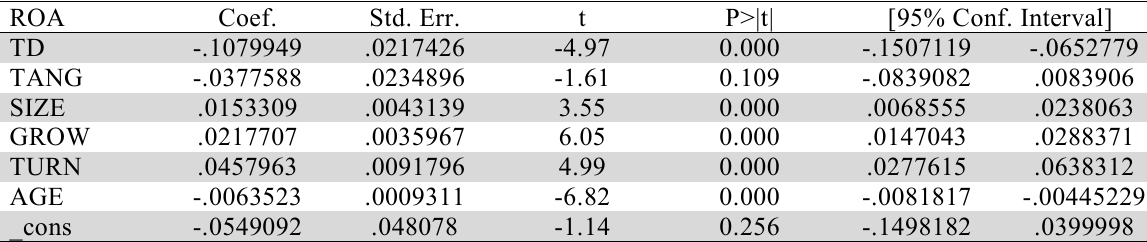
Result of FEM with dependent variable